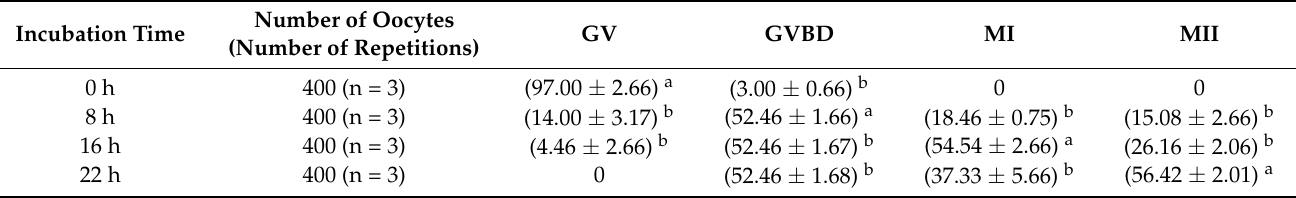
Table 4. Number of cells at different stages of IVM oocyte in control groups.